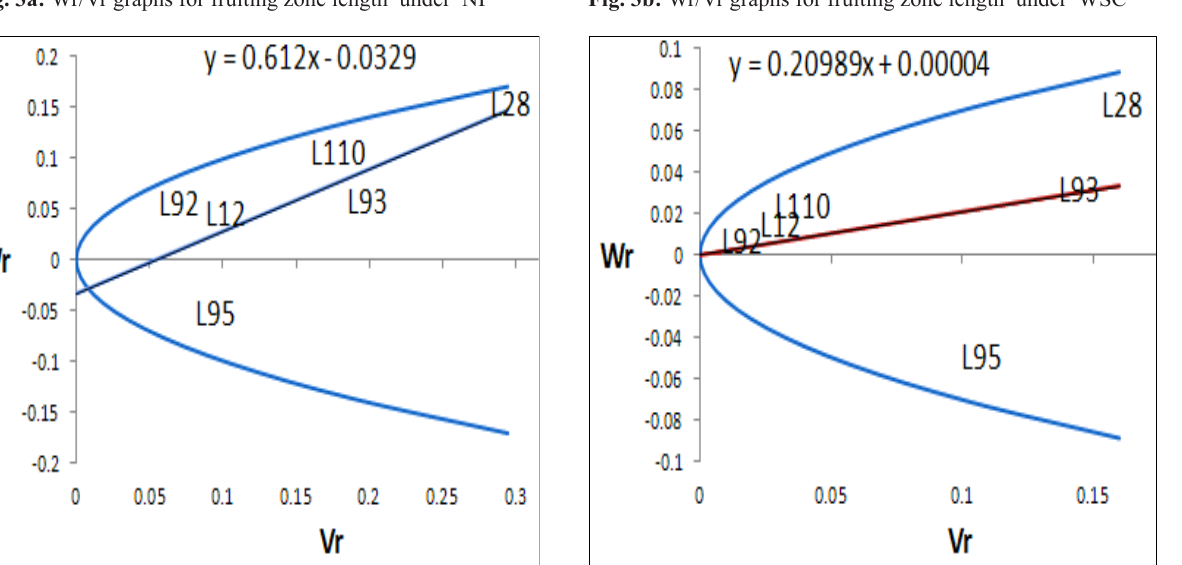
Fig. 4a: Wr/Vr graphs for capsule length under NI Fig. 4b: Wr/Vr graphs for capsule length under